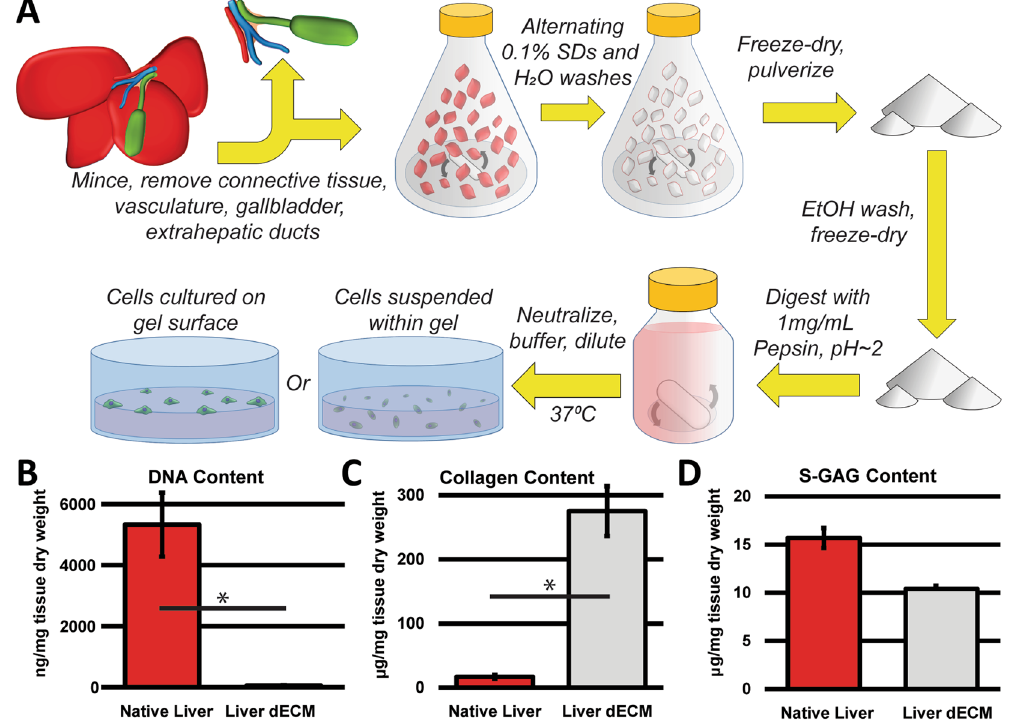
Figure 1. Liver Decellularization and Cell Encapsulation. ( A ) Schematic of the liver decellularization and cell encapsulation process. Porcine liver is subjected to mincing and alternating washes of SDS and water, followed by lyophilization and milling, and sterilization. Liver dECM is digested for 48 hours at room temperature under heavy agitation. Cholangiocytes in media are either combined with the neutralized, cold pre-gel for encapsulation, or plated on top of a pre-formed gel. ( B ) DNA content of liver dECM is ~1% that of native liver, indicating complete decellularization. ( C ) Collagen content by weight is increased in liver dECM after decellularization due to removal of cellular material. ( D ) ECM-based sulfated glycosaminoglycans (GAGs) are retained after decellularization. Error bars ± SD, n = 3, * p <